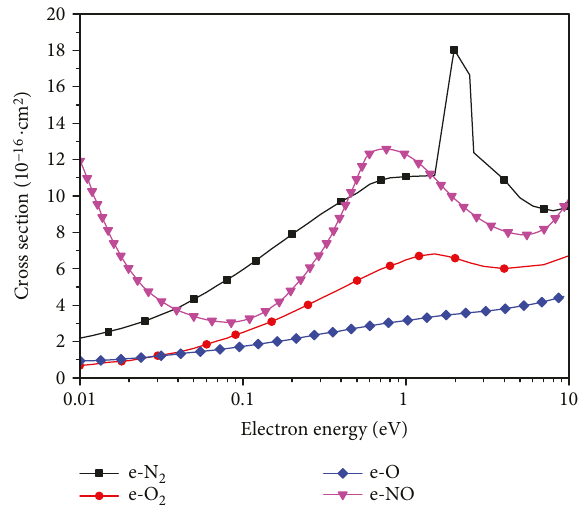
Figure 2: Collision cross sections as a function of electron energy for N 2 , O 2 , O, NO . Data is cited from [33] and